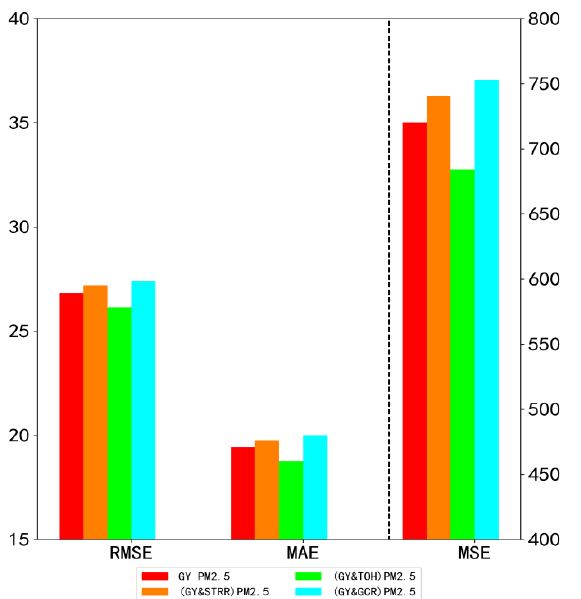
Figure 6. Two-coordinate error histogram of forecast results based on PM2.5 in different regions.